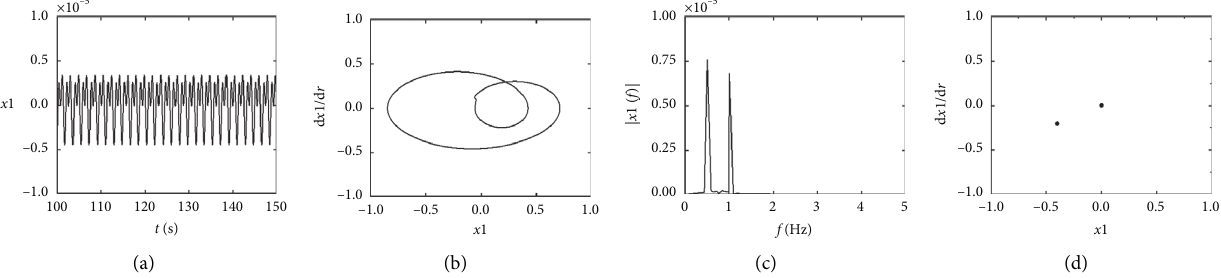
Figure 15: Numerical analysis results at ω � 1250rad/s, k and (d) Poincare